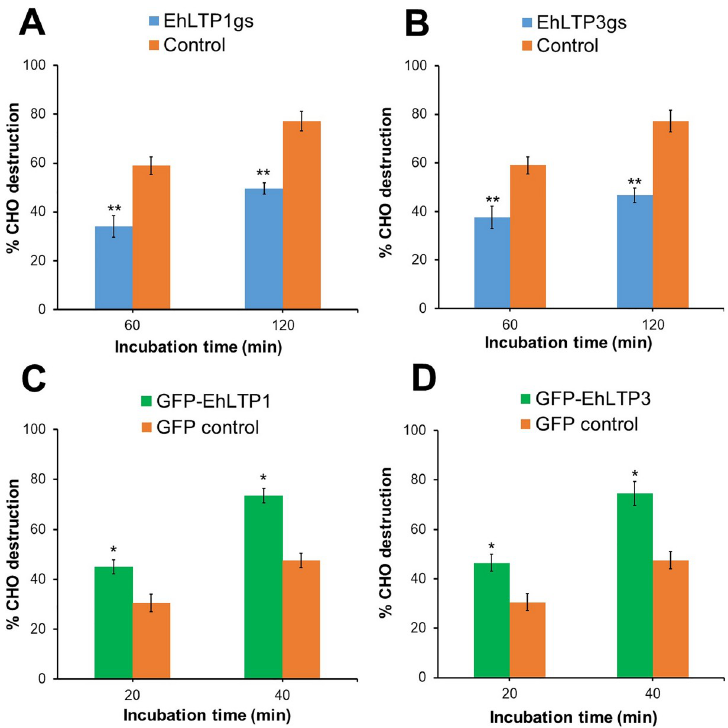
Fig 7. Effects of gene silencing of EhLTP1 (A) and EhLTP3 (B) or overexpression of EhLTP1 (C) and EhLTP3 (D) on the cytopathy of E . histolytica trophozoites against mammalian cells. Destruction of Cell Tracker Blue labelled CHO cells by E . histolytica transformants was assayed as described in Methods. The number of remaining adherent CHO cells was proportional to the intensity of Cell Tracker Blue signal and expressed as the percentage of the fluorescence of remaining untreated CHO cells. The experiment was repeated three times independently in duplicates (N = 3 with error bars indicating standard deviation). Statistical comparisons were made by Student’s t-test ( � P � 0.05, �� P � 0.005, ��� P �